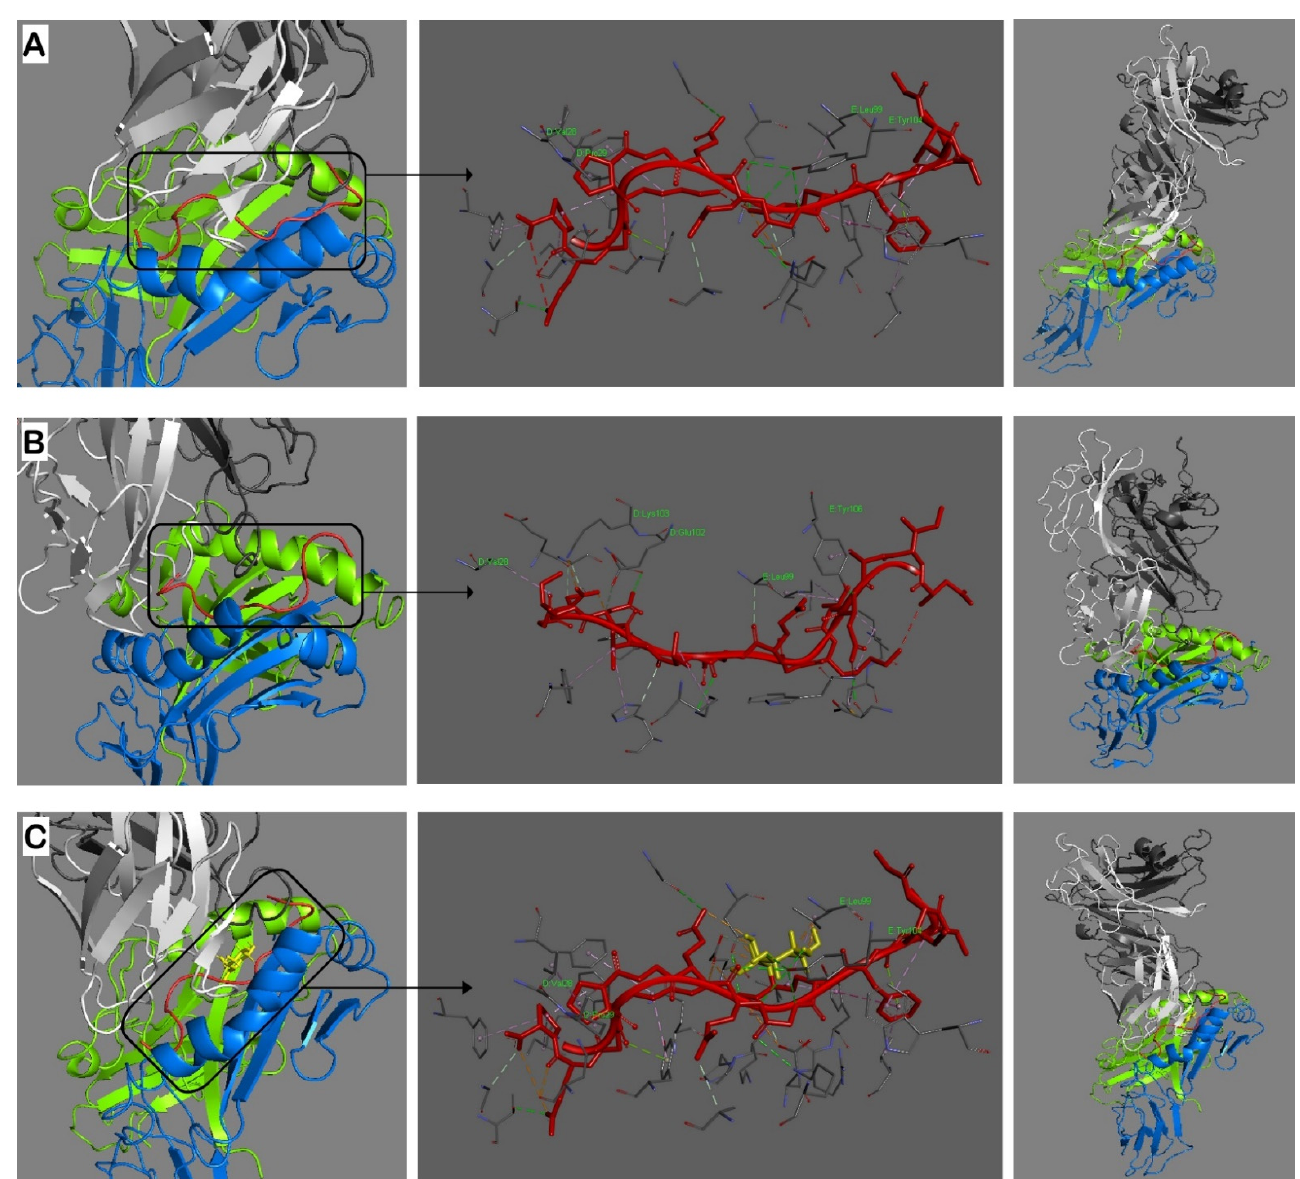
Figure 2. Molecular models of interaction in the trimolecular complex HLA-DRB1*04:01 (bright green/blue)—peptide (red)— α / β TCR (white/grey). ( A ): CII259-273 peptide; ( B ): ASNase67-81 peptide; ( C ): Gal264-CII259-273 peptide. Hydrogen bonds are indicated by dashed lines. Amino acid residues from both α and β chains of the TCR important for interactions with the peptides are shown in bright green. Gal264 in CII259-273 peptide is yellow. Alpha and beta chains of the MHCII are bright green and blue, respectively. Alpha and beta chains of the TCR are white and gray, respectively. The docking was conducted by using ClusPro 2.2 and the results were visualized using Discovery Studio 2016 V16.1.0.